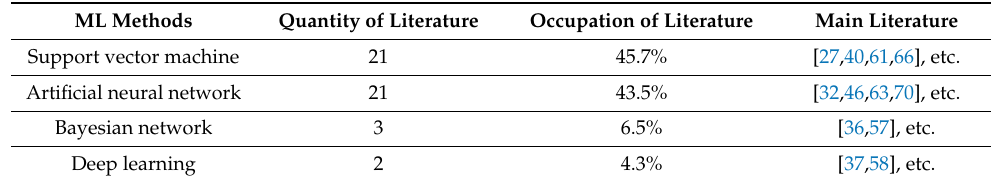
Table 1. Categories of ML methods in RC fault diagnosis.